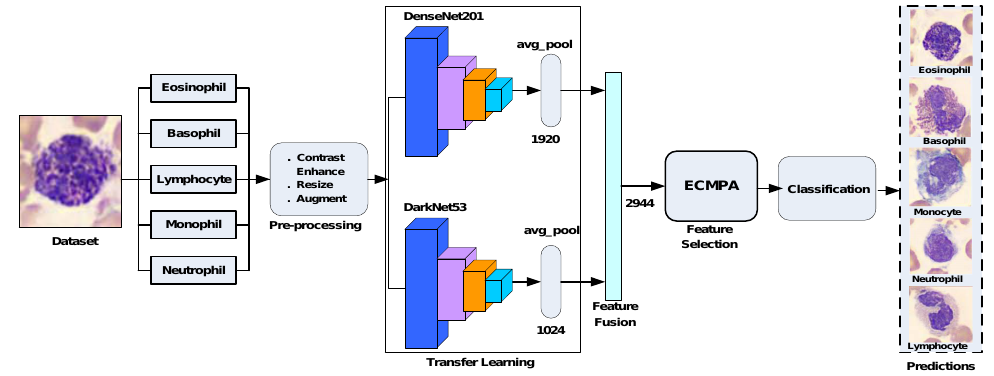
Figure 3. Pipeline of proposed WBCs classification